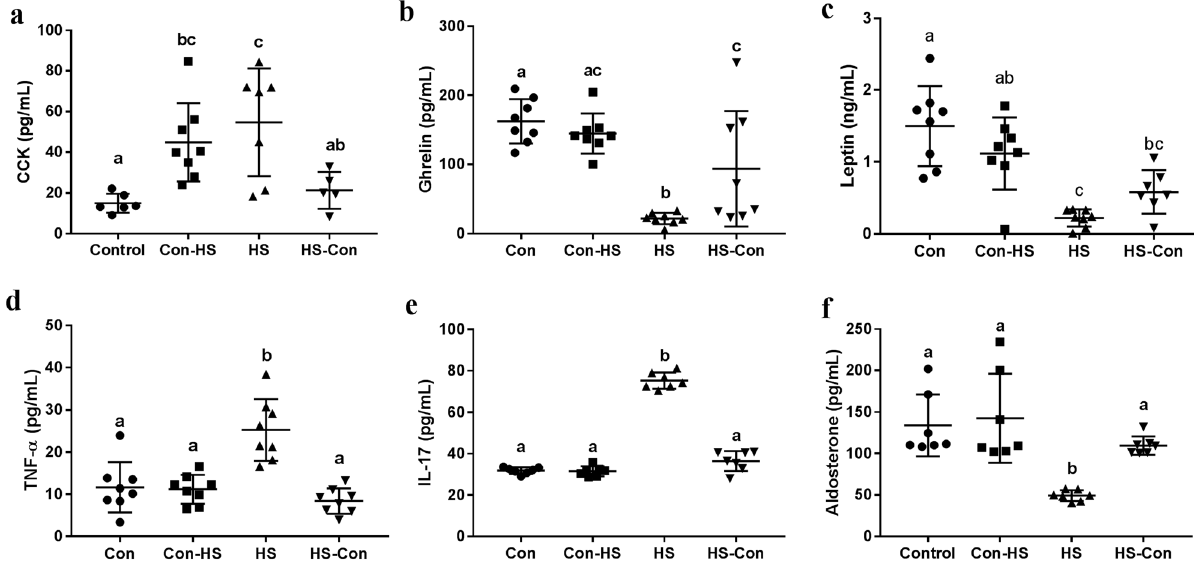
Fig. 3 Microbiota transplant regulated gastrointestinal hormones and alleviated systemic in fl ammation. The concentrations of cholecystokinin (CCK, P = 0.002) ( a ), des-acylated ghrelin ( P < 0.001) ( b ), leptin ( P < 0.001) ( c ), tumor necrosis factor (TNF- α , P < 0.001) ( d ), interleukin 17 (IL-17, P < 0.001) ( e ) and aldosterone ( P < 0.001) ( f ). Data are presented as means ± standard error of the mean (s.e.m), and bars which do not share the same letter are signi fi cantly different from each other ( P < 0.05). Con, gerbils drank tap water ad libitum and received sterile saline as sham-CMT via oral gavage; Con-HS, Con gerbils received microbiota from HS gerbils via oral gavage; HS, gerbils drank water with 8% NaCl ad libitum and received sterile saline as sham-CMT via oral gavage; HS-Con, gerbils drank HS water ad libitum and received microbiota from the Con gerbils via oral